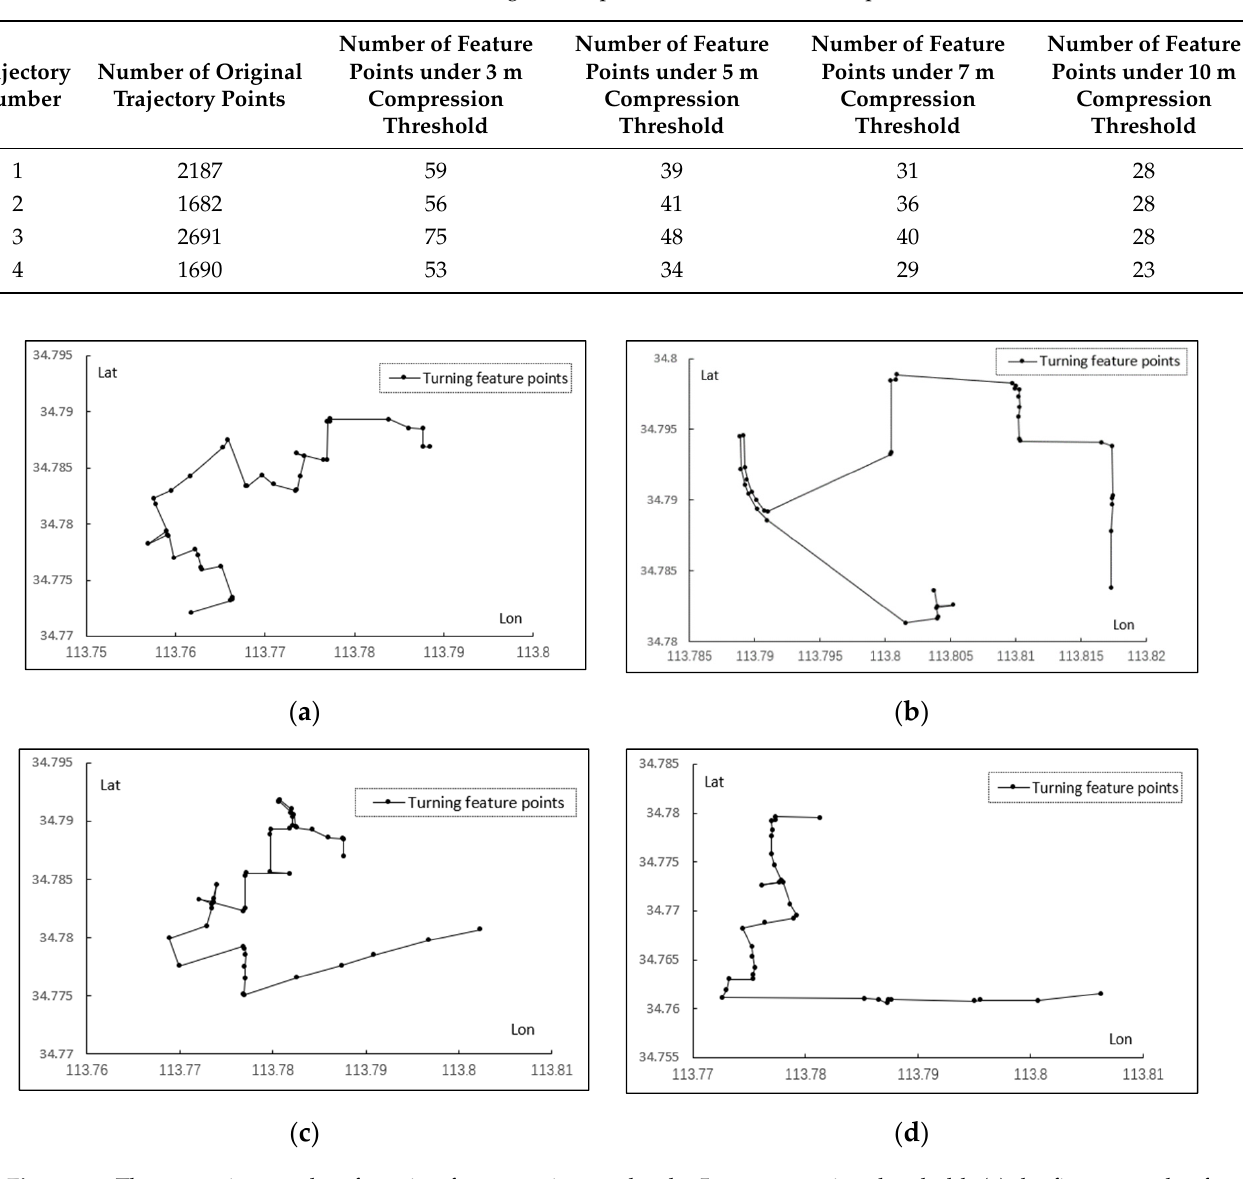
Table 1. Extraction results of Turning feature points under different compression thresholds.